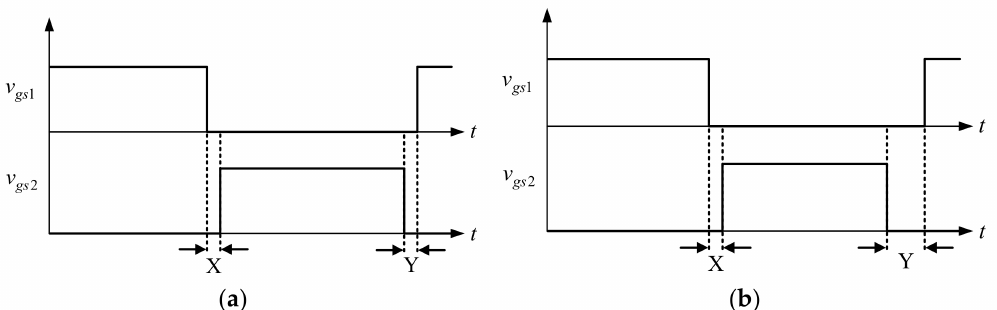
Figure 14. Auto-tuning technique with X and Y called the first blanking time and the second blanking time, respectively: ( a ) with X = Y ; ( b ) with X (cid:54) = Y.